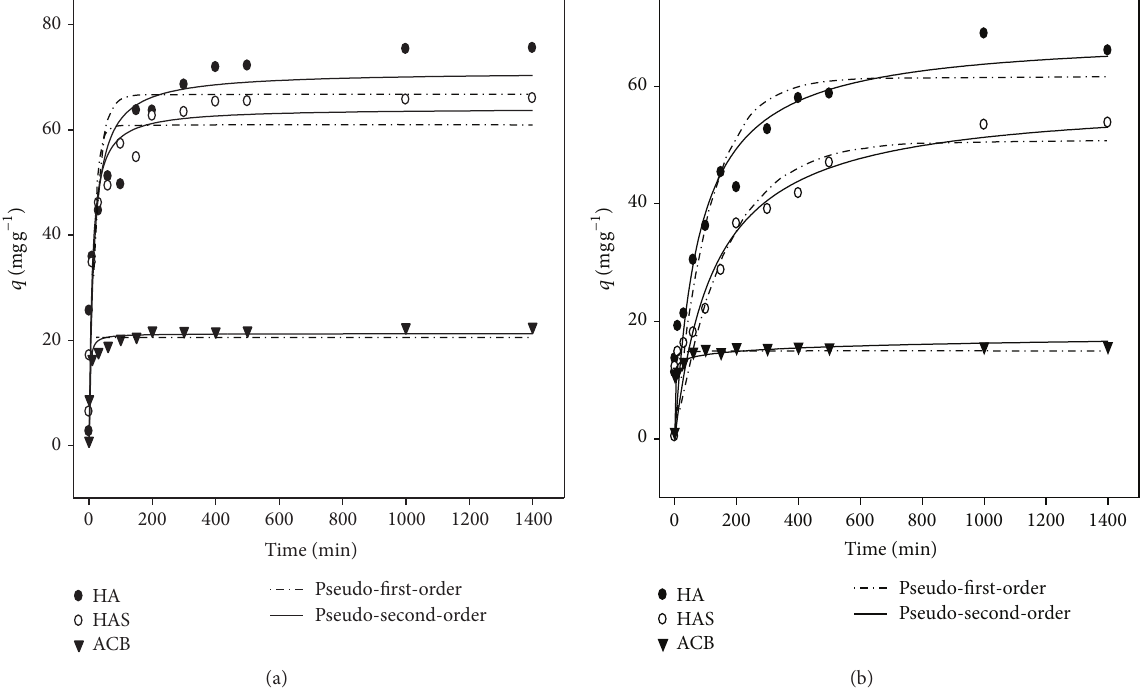
Figure 2: Kinetic pseudo-first-order and pseudo-second-order models for the adsorption of BSA on the surface of hydroxyapatite (HA), synthetic hydroxyapatite (HAS), and active babassu coal (ACB) at pH 4.0 (a) and pH 7.0 (b) and 25 ∘ C/24h.